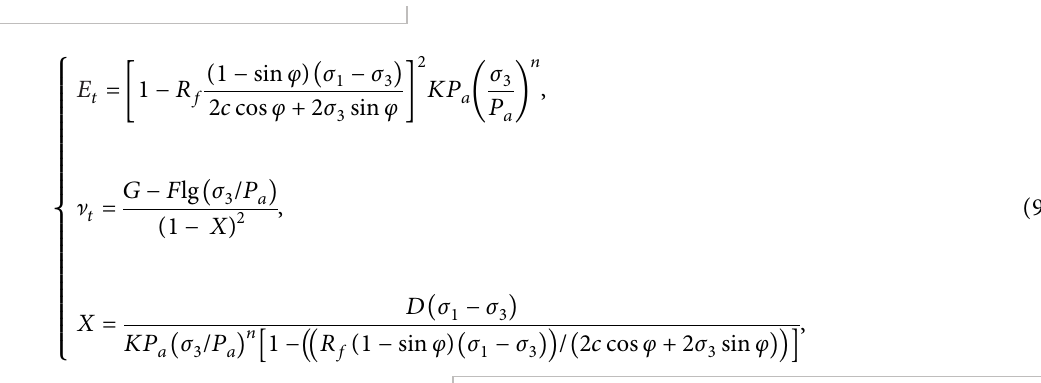
− σ − ε 1 3 ) 1 , (b) lg ( E i / P a )